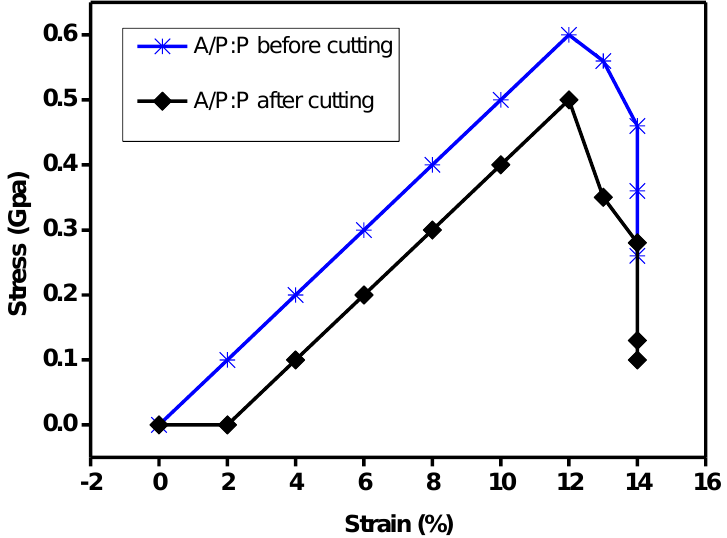
Figure 12. Tensile mechanical properties of hydrogel samples. Typical stress–strain curves for hydrogels and variation in elongation at fracture, hardness, and initial tensile modulus of A/P:P hydrogel with high concentration of PEDOT:PSS before cutting and after cutting, and the maximum stress with different values of x, respectively.